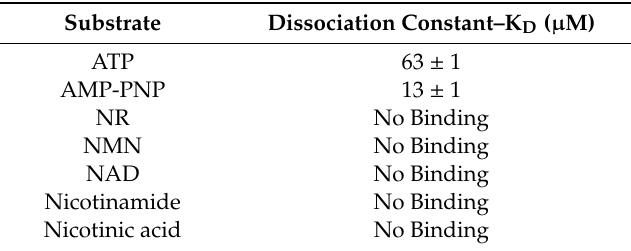
The error represents the upper and lower values from two